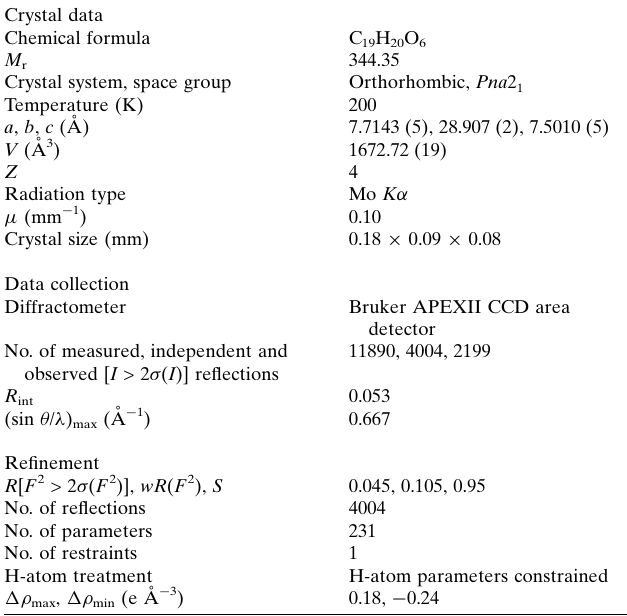
Table 2 Experimental details. Crystal data Chemical formula